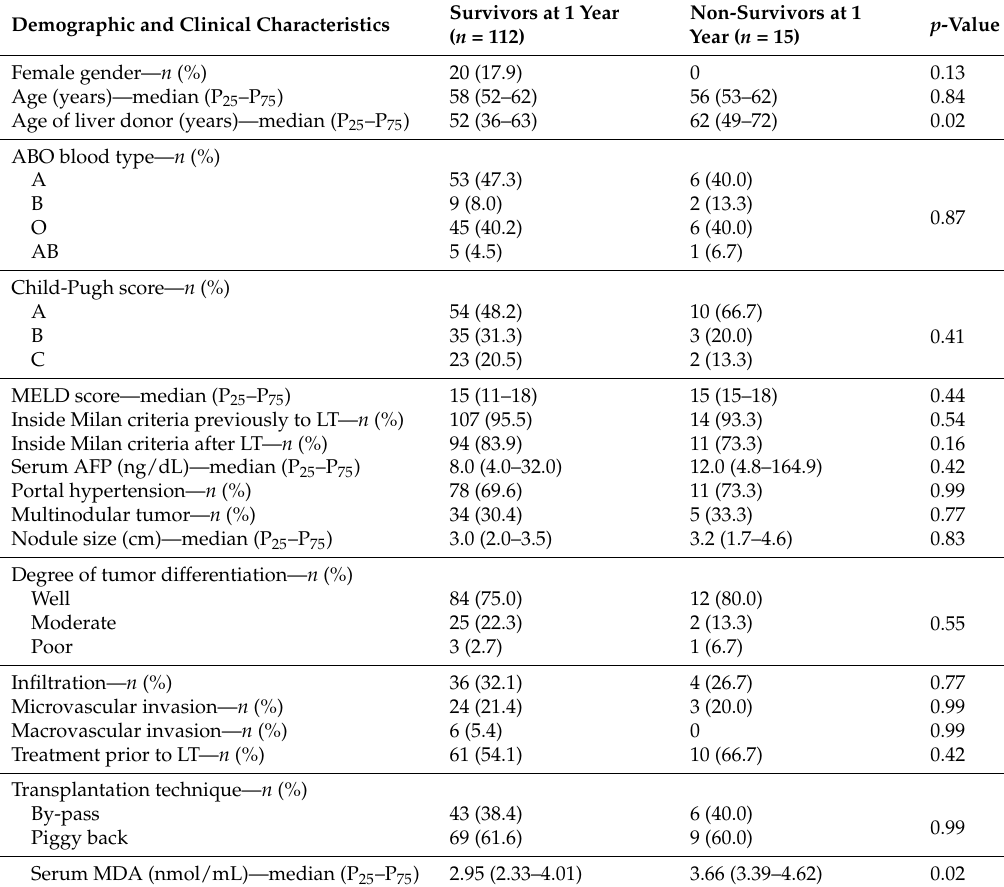
Table 2. Demographic and clinical characteristics of 1-year survivors and non-survivors undergoing liver transplantation for hepatocellular carcinoma.